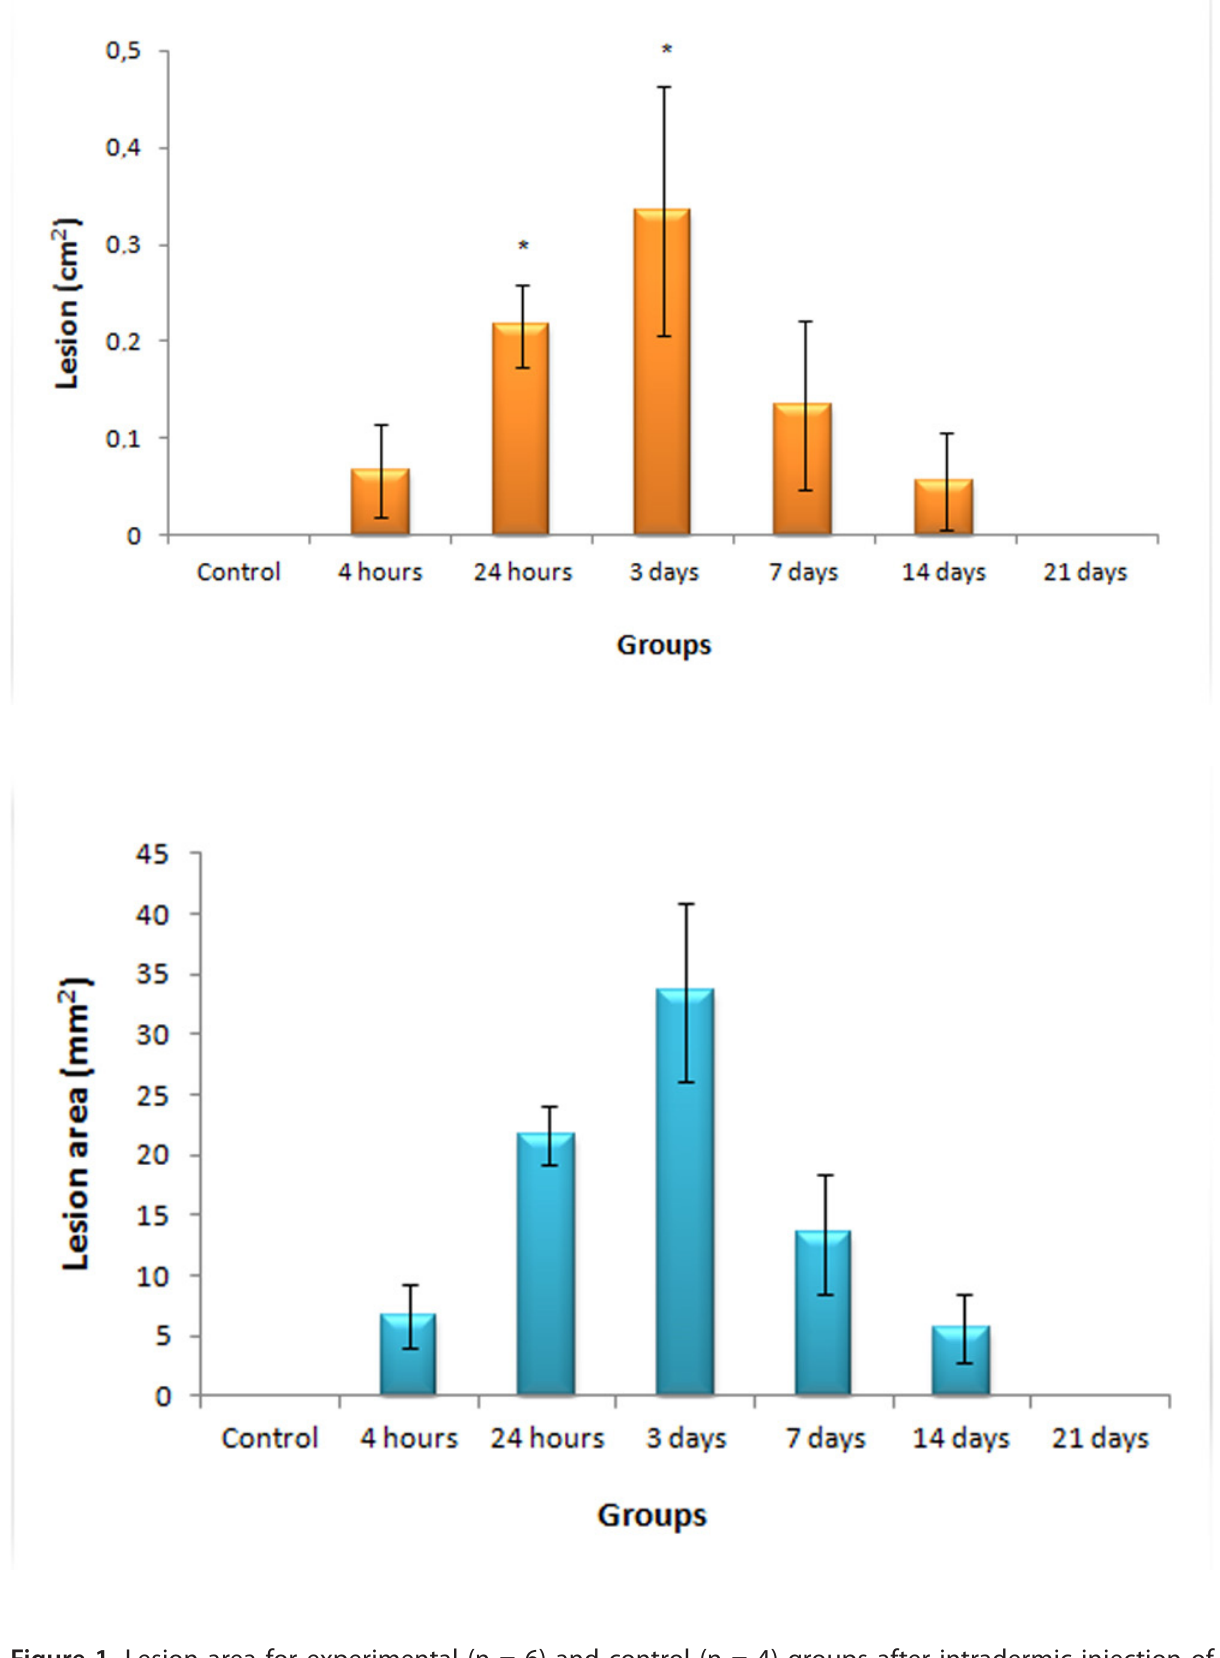
Figure 1. Lesion area for experimental (n = 6) and control (n = 4) groups after intradermic injection of Bothrops cotiara venom. Venom (100 µg/50 µL) was injected in the dorsal area between the hind limbs. Control mice received 0.9% NaCl solution. At different times after inoculation, the animals were euthanized and the outer skin surface was photographed and measured. Results are represented as mean ± SEM. *Statistical significance when compared with control group for p <